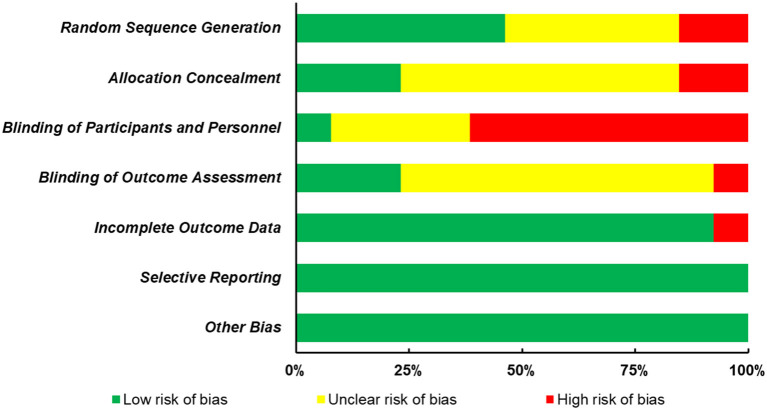
Risk of bias graph.